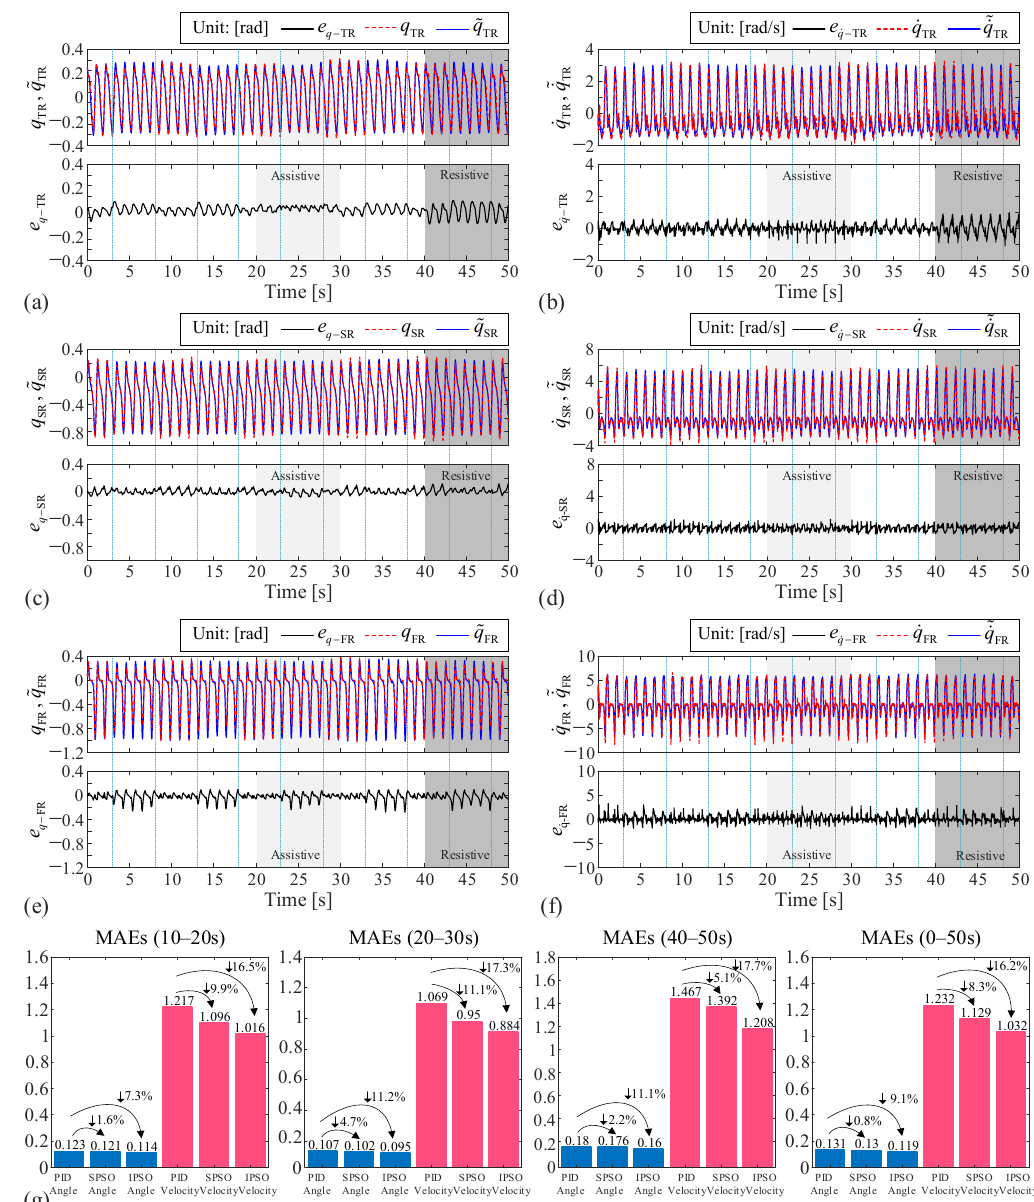
Figure 4. Tracking results of Case I. ( a )–( f ) display the angle and velocity tracking results corresponding to the exoskeleton hip, knee, and ankle joints, respectively. ( g ) Mean accumulated errors (MAEs) in both position and velocity during the first stable stage (10–20 s), the stage with an assistive human effect (30–40 s), the stage with a resistive human effect (40–50 s), and the whole process (0–50 s). The reductions brought by the SPSO and the IPSO algorithms are denoted. To further quantify the accuracy, the objective function, i.e., the MAE, is examined. The first stable stage (10–20 s), the stage with an assistive human effect (30–40 s), the stage with a resistive human effect (40–50 s), and the whole process (0–50 s) are studied sepa ‐ rately. A comparison of the results indicates that the PID coefficients obtained via the model ‐ based tuning method perform well in angle tracking, and the SPSO algorithm could provide a low level (<5%) reduction in the MAE in position. Due to the torque